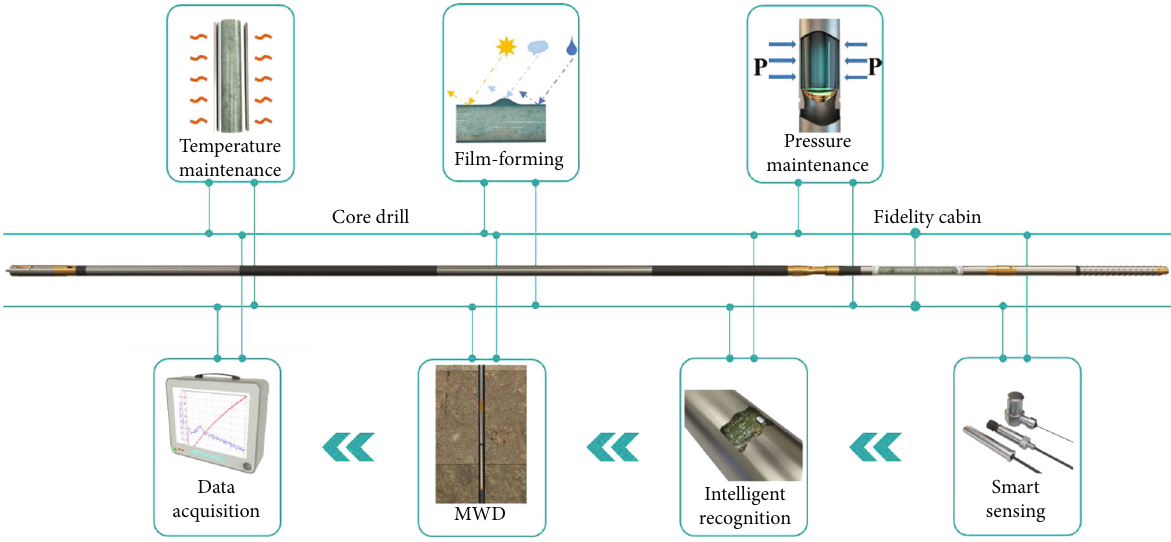
Figure 1: Module composition of the deep in situ fi delity coring